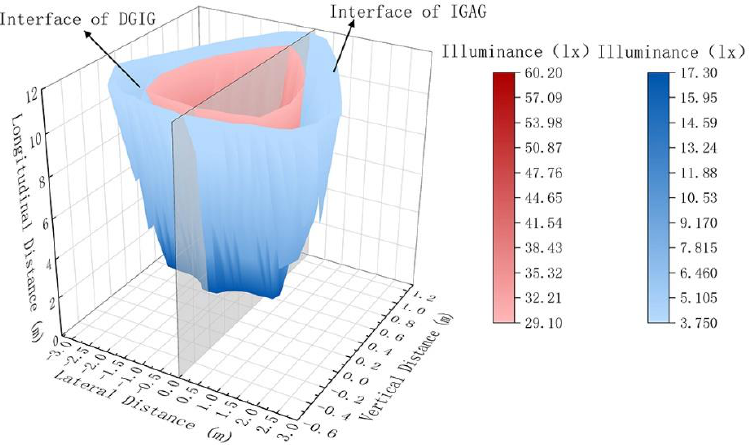
Figure 13. Spatial distribution of glare at the longitudinal distance of 3 m to 12 m.